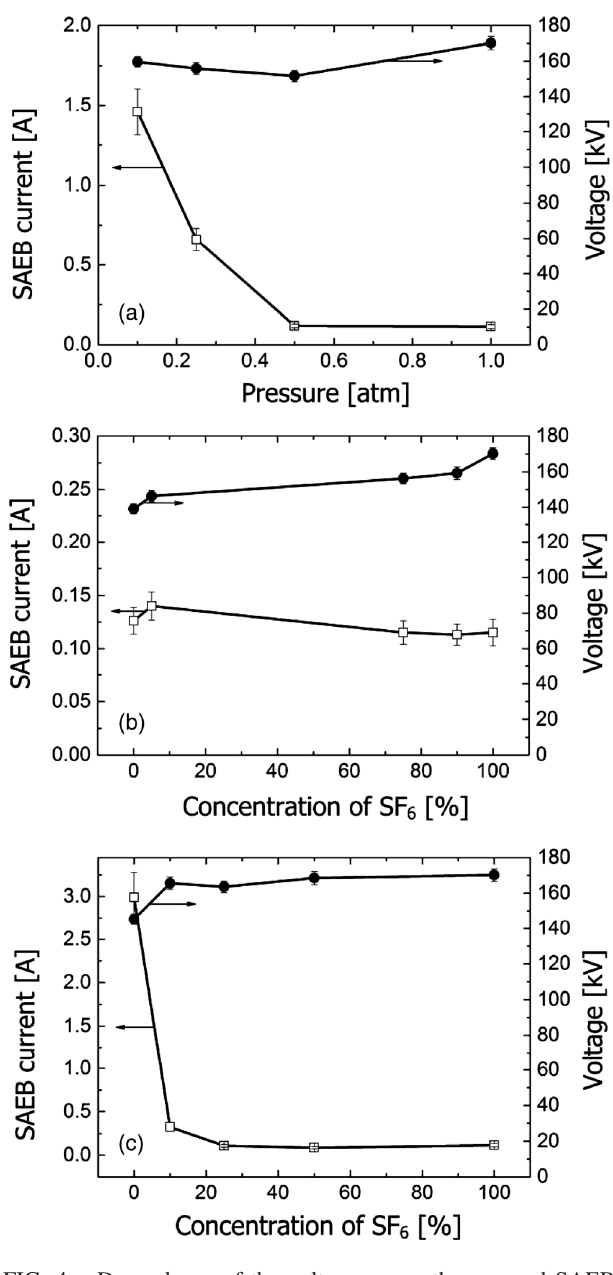
FIG. 5. Typical waveforms of the voltage pulse and SAEB current in SF 6 at atmospheric pressure. Interelectrode distance d ¼ 12